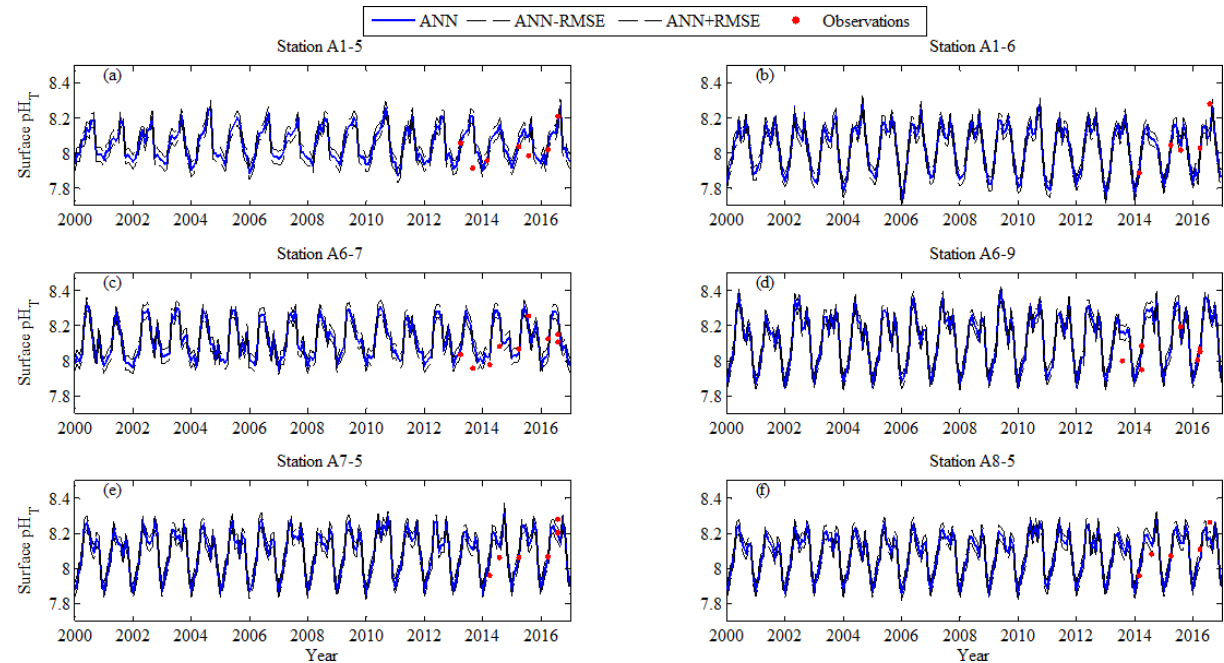
Figure 10. Comparison of surface pH T retrieved by the ANN model using Changjiang biology FVCOM output with corresponding ob- servations at six sites with repeated sampling for 3 to 4 years. Red dots represent observed pH T , solid blue line represents retrieved pH T , and dotted black lines represent upper and lower bounds of the ANN model accuracy (ANN ± RMSE). (a) Station A1-5; (b) station A1-6;